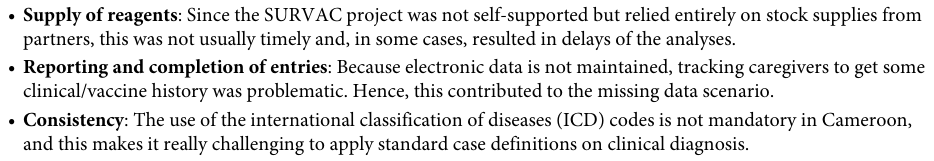
Table 7. Some of the observed indicators/factors influencing surveillance programme performance in